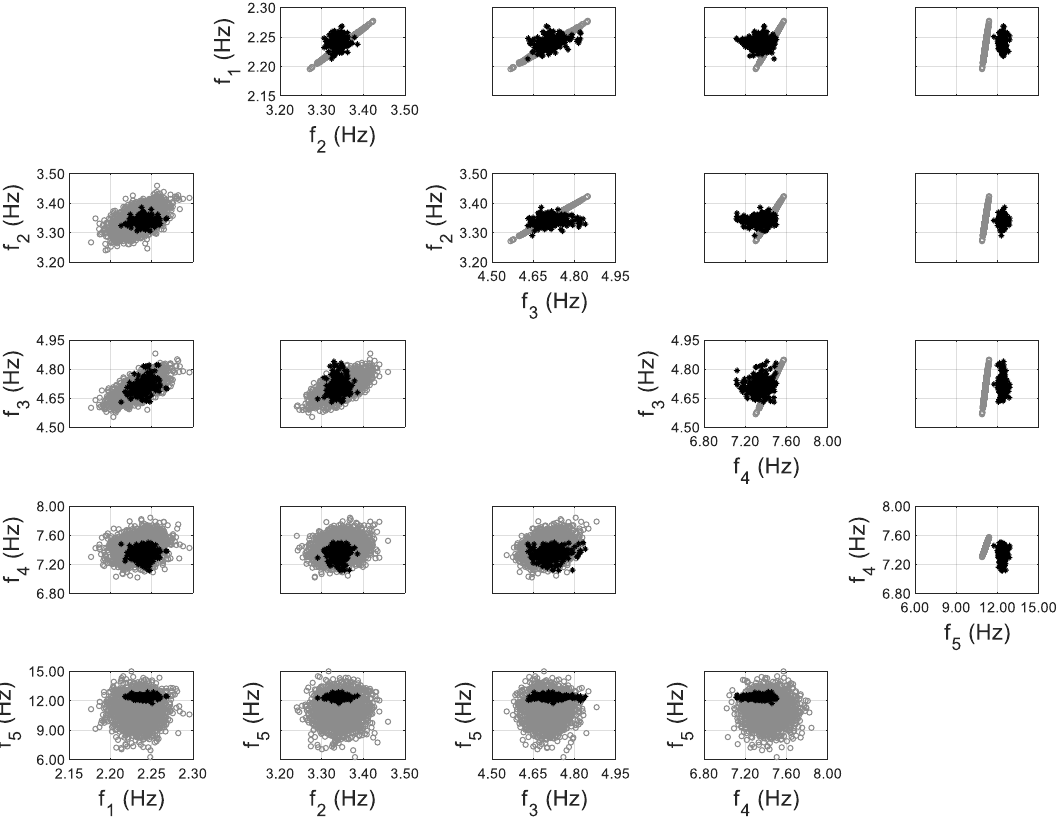
Figure 9. Model-predicted (gray) vs. identified (black) natural frequencies, using zero-mean error function (upper triangular subplots denote predictions without error function considered; lower triangular subplots denote predictions with propagation of error function).